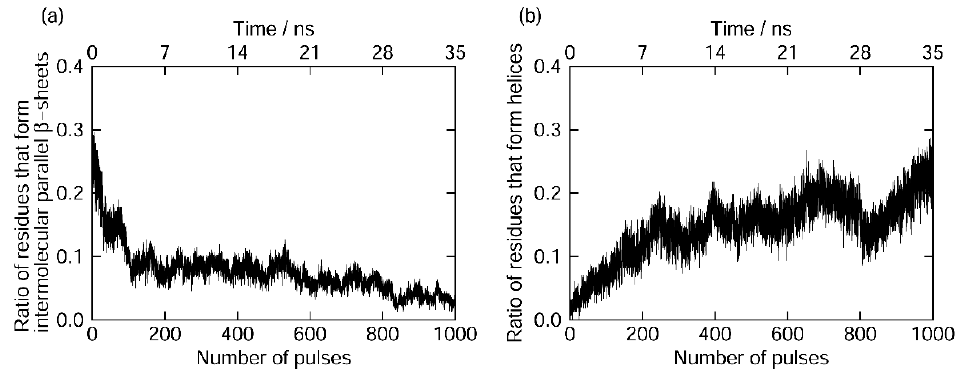
Figure 16. Time series of the ratio of the residues that form ( a ) intermolecular β -sheets and ( b ) helices in one of the nonequilibrium MD simulations.